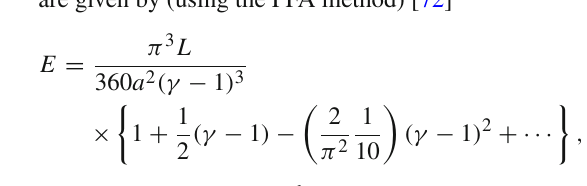
are given by (using the PFA method)